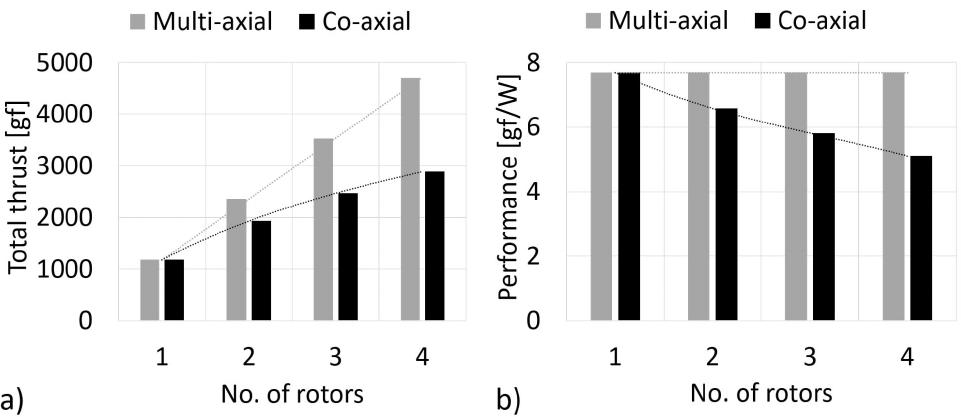
Figure 11. ( a ) Total thrust output and ( b ) System performance for one to four-rotor coaxial systems compared to multi-axial